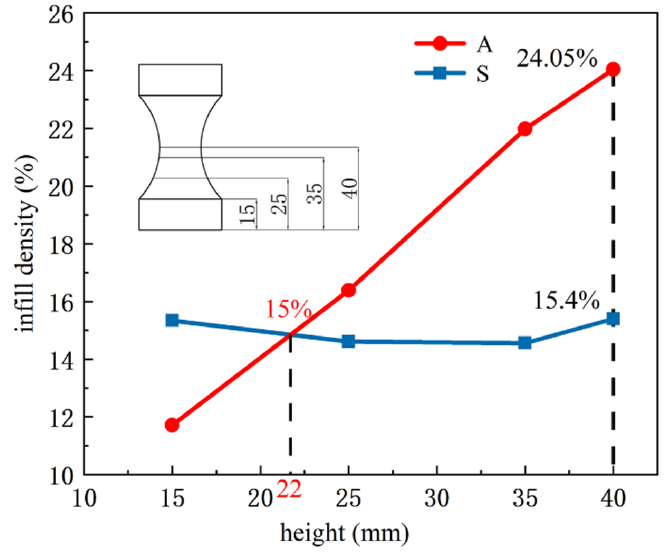
Figure 10. Infill density at a different height (S denotes uniform filling structure, and A denotes